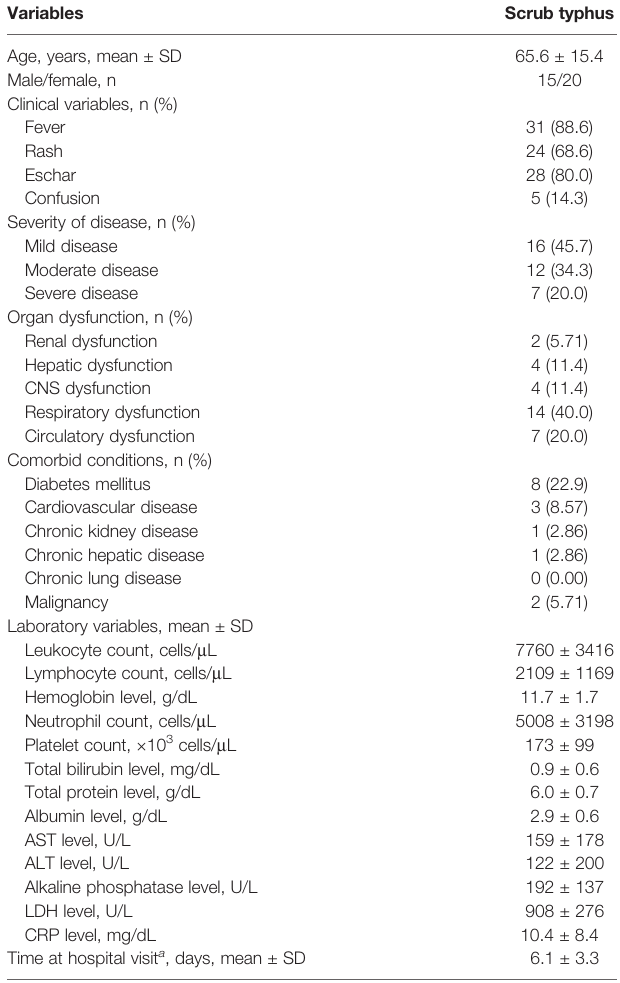
TABLE 1 | Clinical and laboratory characteristics of 35 patients with scrub